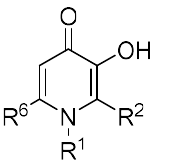
Figure 3. General formula of the 3,4-HPO bidentate chelating unit.